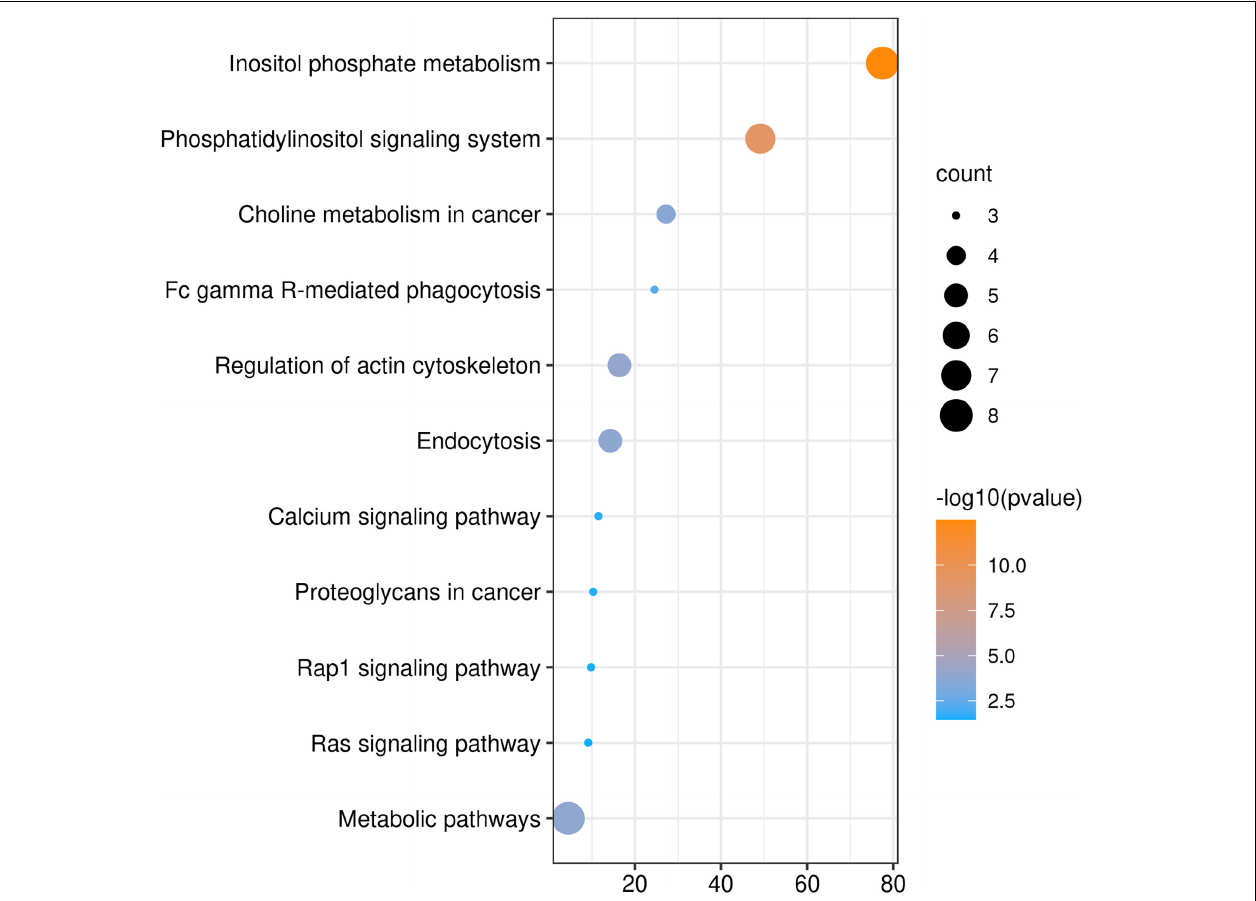
FIGURE 4 | The KEGG enrichment analysis of PLCE1 and its co-expression genes by DAVID database. The size of the circle represents the counts of genes enriched, and the larger the circle, the more genes were enriched. From orange to blue, –10log ( P -value) gradually